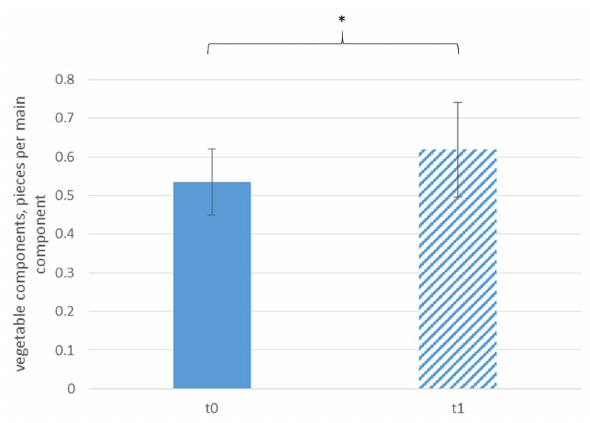
Figure 3. Daily sale of vegetable components per main component according to time; * p < 0.05.